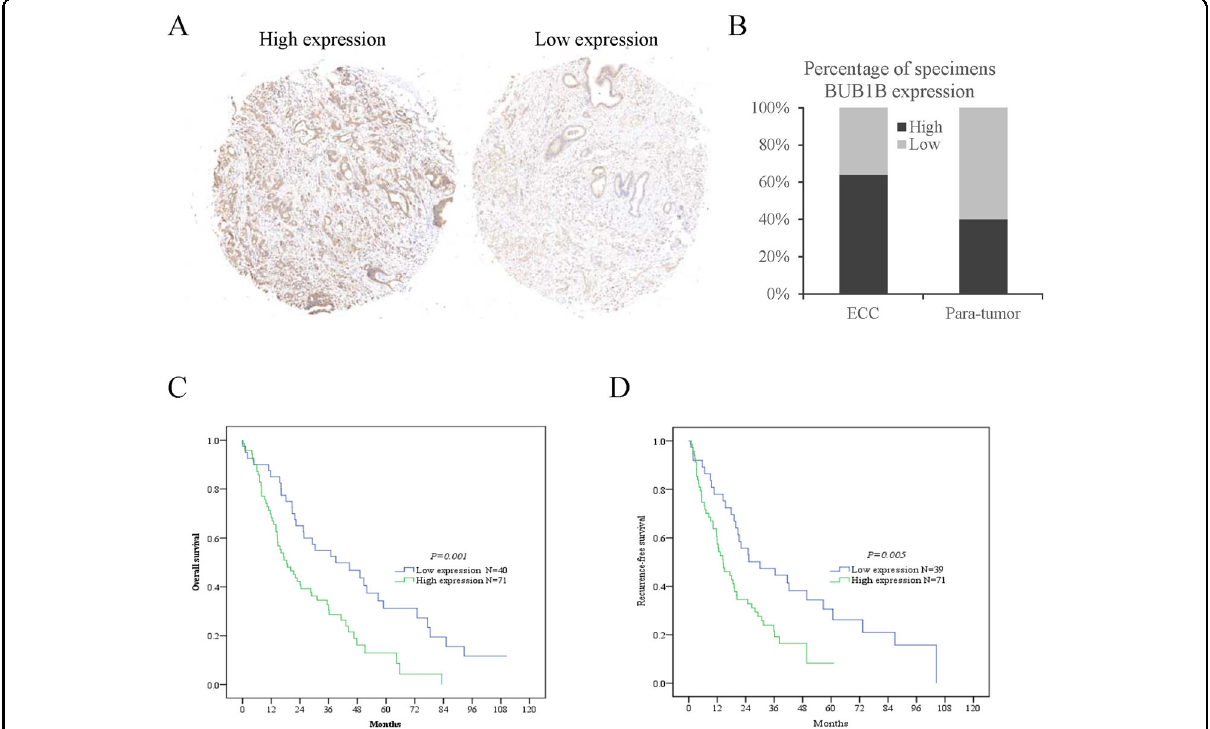
Fig. 7 The clinical signi fi cance of BUB1B in ECC patients. ECC patients with BUB1B high expression had worse overall survival and recurrence-free survival than those with BUB1B low expression. A , B A tissue microarray and IHC staining were performed in 113 ECC patients. C Kaplan – Meier survival analyses were conducted to assess the in fl uence of BUB1B on the overall survival of ECC. D Kaplan – Meier survival analyses were conducted to assess the in fl uence of BUB1B on disease-free survival of ECC.